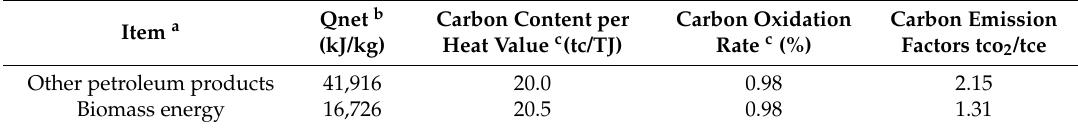
Figure 4. The proportion of the energy consumption in each sector. As shown in Figure 4, the majority of terminal energy consumption came from the industrial sector, accounting for 77.78%; the household sector accounted for 10.70%, the transportation sector 3.67%, the agricultural sector 1.79%, the commerce sector 1.91%, the construction sector 1.18% and the service sector 2.96%. The industrial sector will always have a dominant position in energy consumption. With the optimization of the industrial structure, adjustments in the energy structure, the development of renewable energy sources, the reduction of the proportion of traditional energy sources, the improvement of energy efficiency and introduction of energy policies, the trend changes in the terminal energy consumption structure are obvious. The proportion of energy consumption in the industrial sector will continue to decline, while the proportion of the household and service sector will gradually rise in the ISO, TOS and LCD. In the LCD, the proportion of energy consumption in the industrial sector continued to decline, and it accounted for 52.412%, which was 19.81% lower than the TOS. The proportion of energy consumption in the household and service industries continued to rise; the household sector accounted for 17.95%, an increase of 7.92%, and the service industry accounted for 16.47%, an increase of 13.51% compared with the base year. The